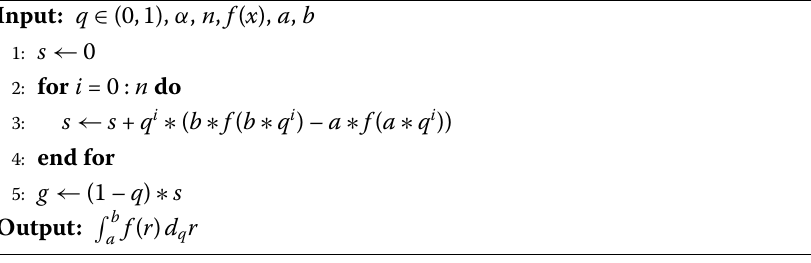
Algorithm 5 The proposed method for calculating